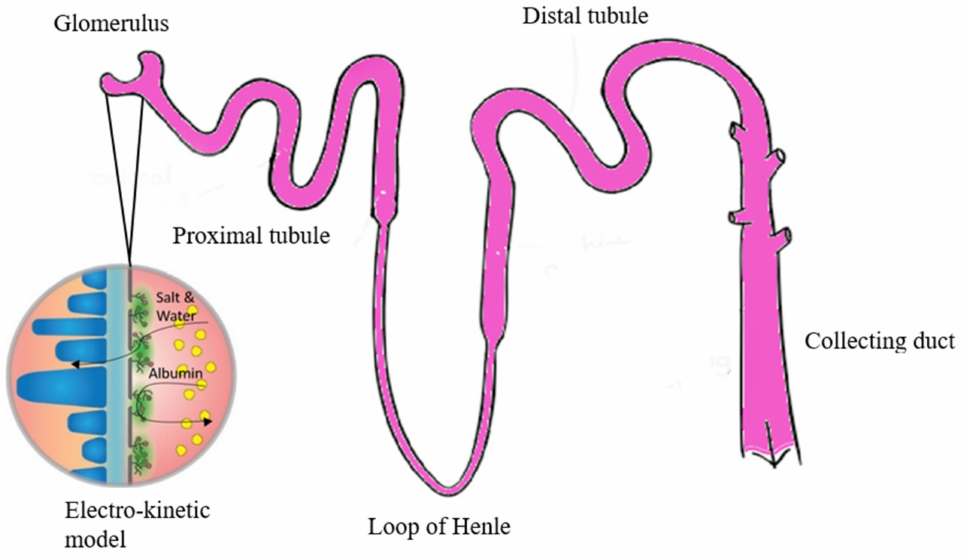
Figure 1. Renal physiology of the kidney.